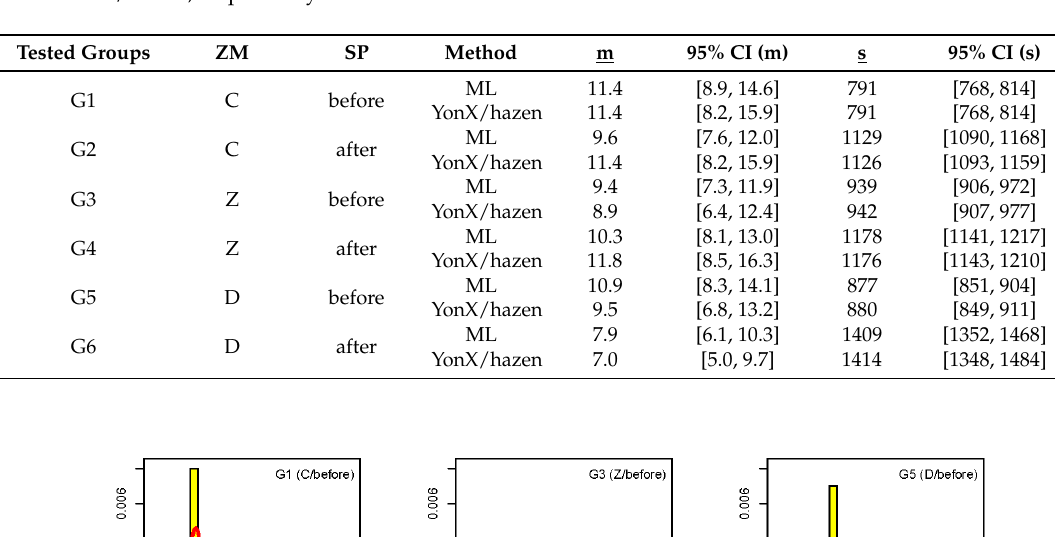
Table 3. Point and interval estimates of the Weibull parameters modulus ( m ) and scale ( s ) based on ML or YonX/hazen, respectively.